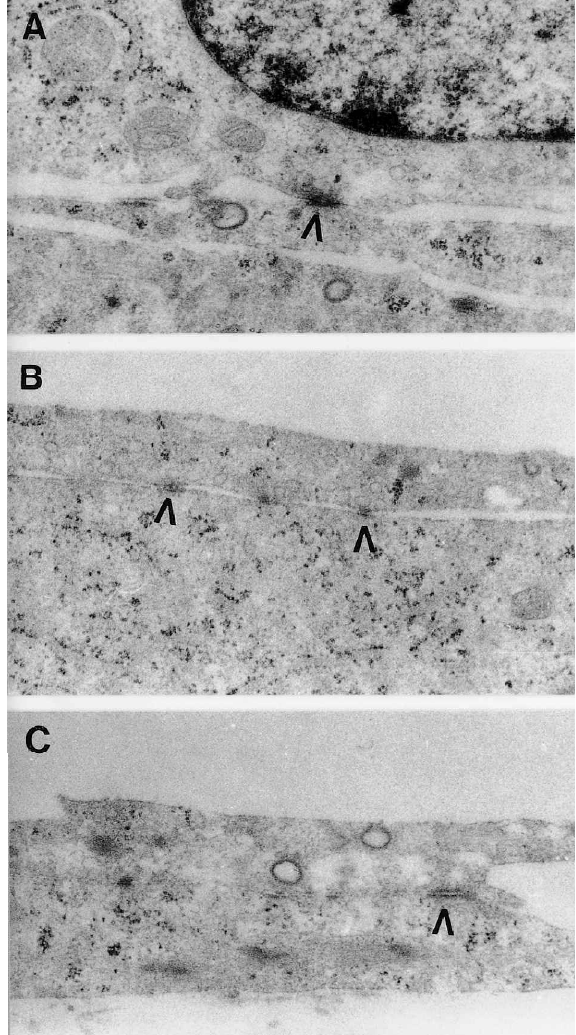
FIG. 2. Ultramorphologic characteristics of HUVEC mono- layers cultured on different matrices. HUVEC cultured on (A) collagen- (B) fibronectin- and (C) gelatin-coated membranes. Note junctional complexes between adjacent cells (arrow- heads). Magnification 30,000 ´